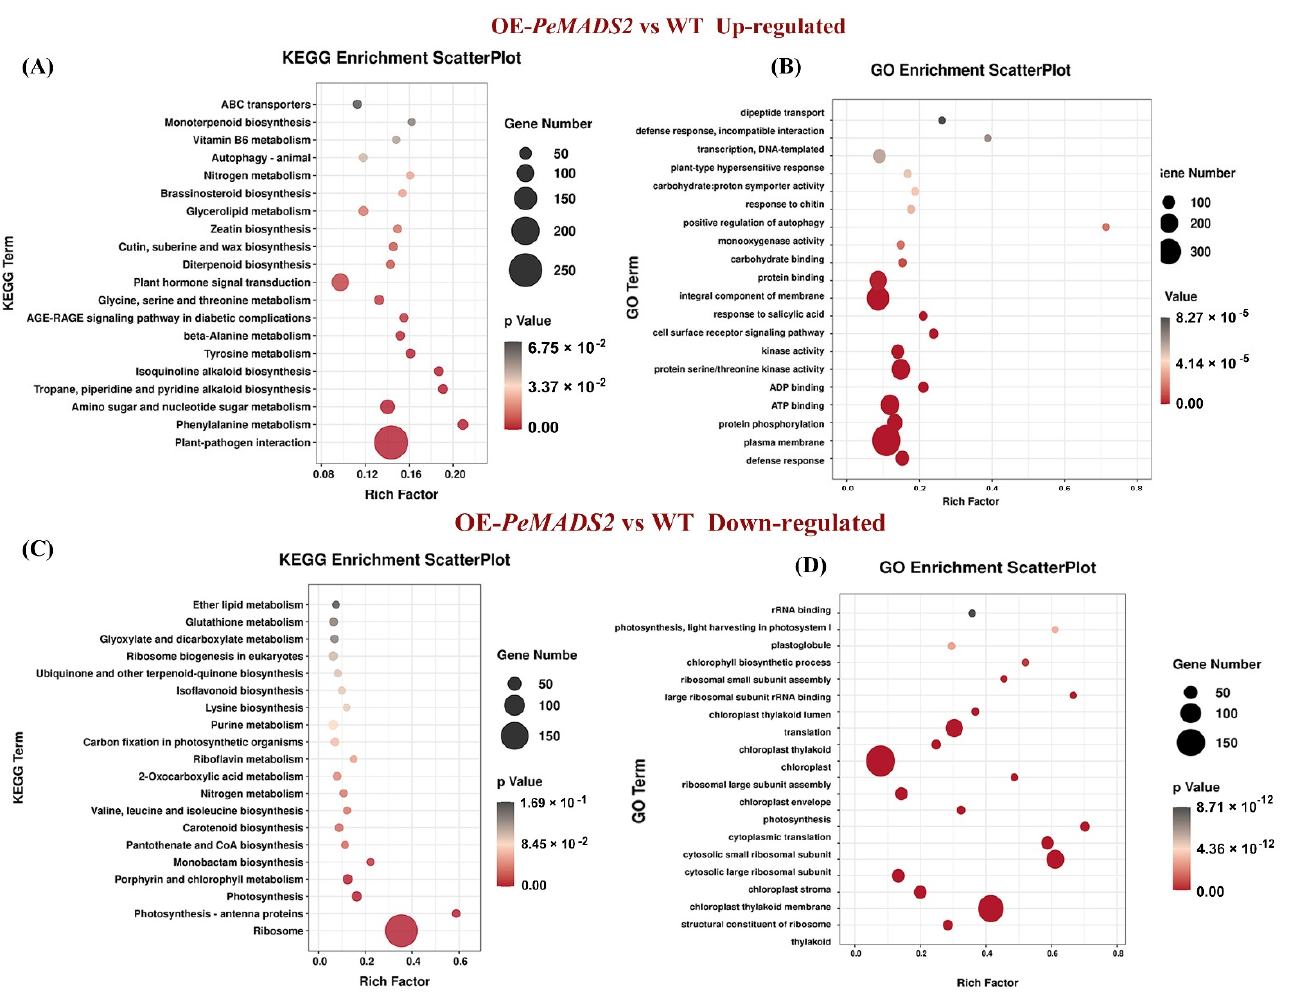
Figure 6. Analysis of RNA-seq data of OE- PeMADS2 lines and wild-type rice plants. ( A , B ): GO and KEGG enrichment analysis of DEGs that were upregulated in OE- PeMADS2 plants. ( C , D ): GO and KEGG enrichment analysis of DEGs that were downregulated in OE- PeMADS2 plants. Low q-values are shown in the dark grey circle, and high q-values are shown in the red circle. The size of a circle represents DEG number. Table 1. DEGs related to rice floral pathway in transgenic